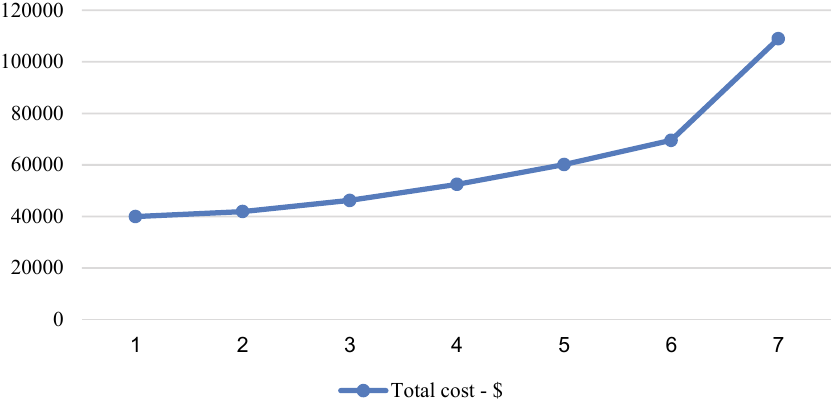
Fig. 6. Sensitivity of total costs by variation the blood